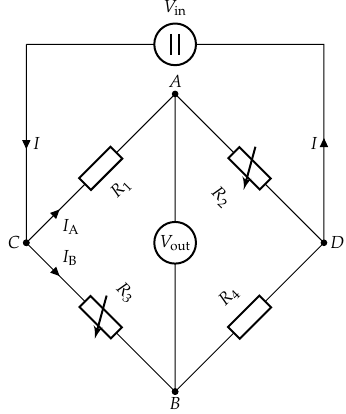
Figure 2. Diagonally configured Wheatstone bridge with two variable resistors (strain gauges) R 2 and R 3 and two passive resistors R 1 and R 4 . This configuration measures normal strain independently of bending strain. V out = B x in Equation